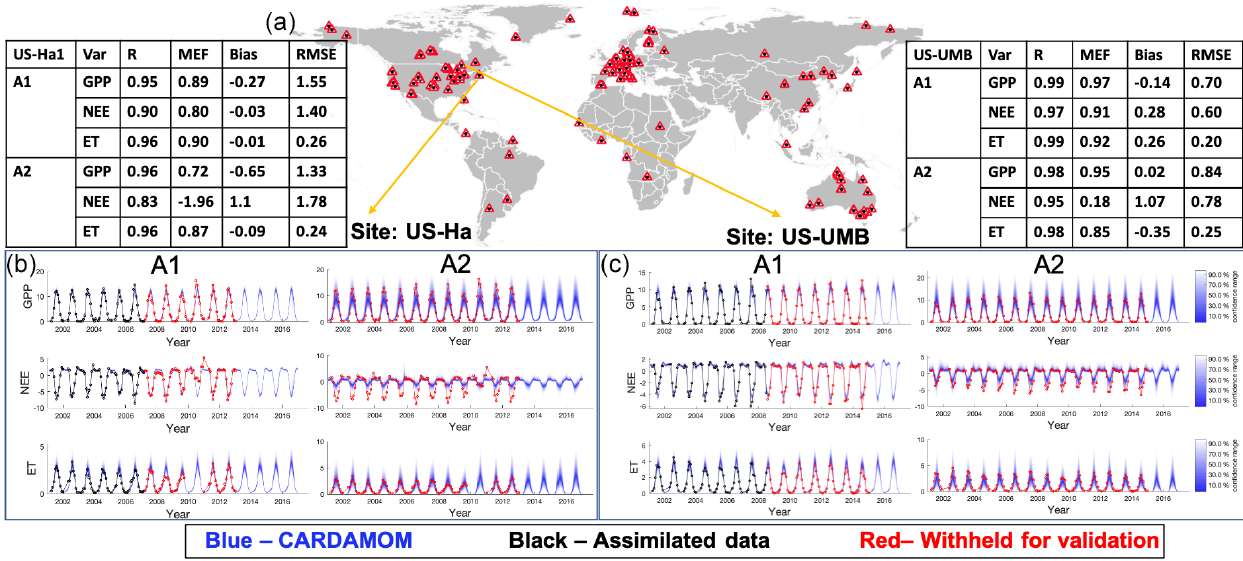
Figure 1. Performance of CARDAMOM model simulations (with 50% of FLUXNET data, Analysis 1 – A1; no FLUXNET data, Analysis 2 – A2). (a) Spatial distribution of FLUXNET tower sites (Tier-1 data). (b) The same time series for the US-Ha site; note that blue lines in GPP, NEE, and ET time series are outputs from model simulations. (c) Time series of CARDAMOM simulations for the US-UMB site; the observed time series from flux towers are also plotted for comparison. Black lines are the first 50% of FLUXNET observations used for data assimilation, while the red lines are the remaining 50% of FLUXNET observations used for validation. The validation metrics in the tables are all from the prediction window for the two selected sites. Table 1. Monthly-based residuals in assimilation and prediction windows (Fig. 1).